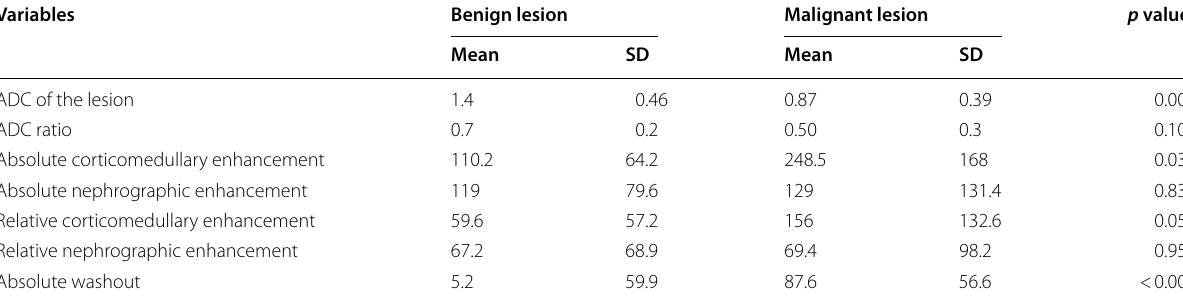
Table 5 Comparisons of benign versus malignant lesions as regard quantitative multiparametric MR analysis: Variables